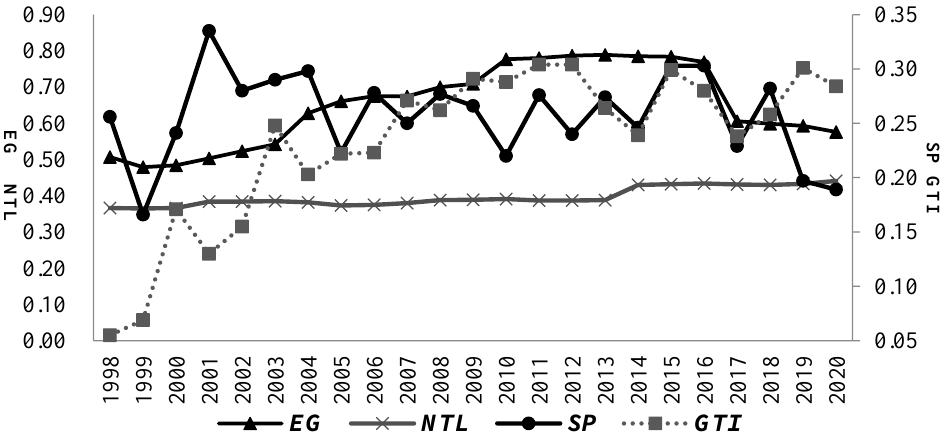
Figure 1. Global Moran’s I test results of the four variables.